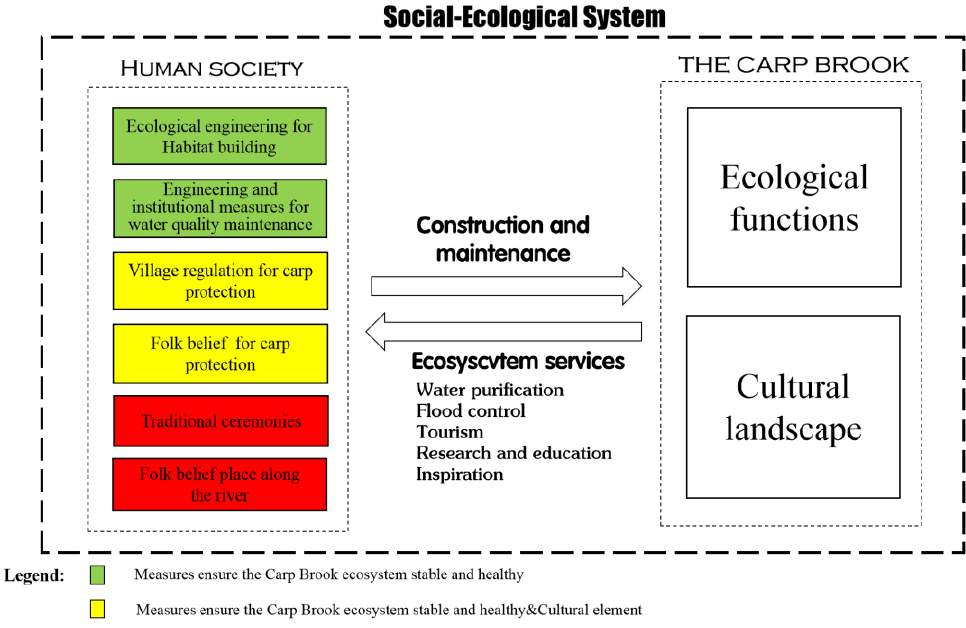
Figure 4. The interaction between the Puyuan village society and the Carp Brook ecosystem.